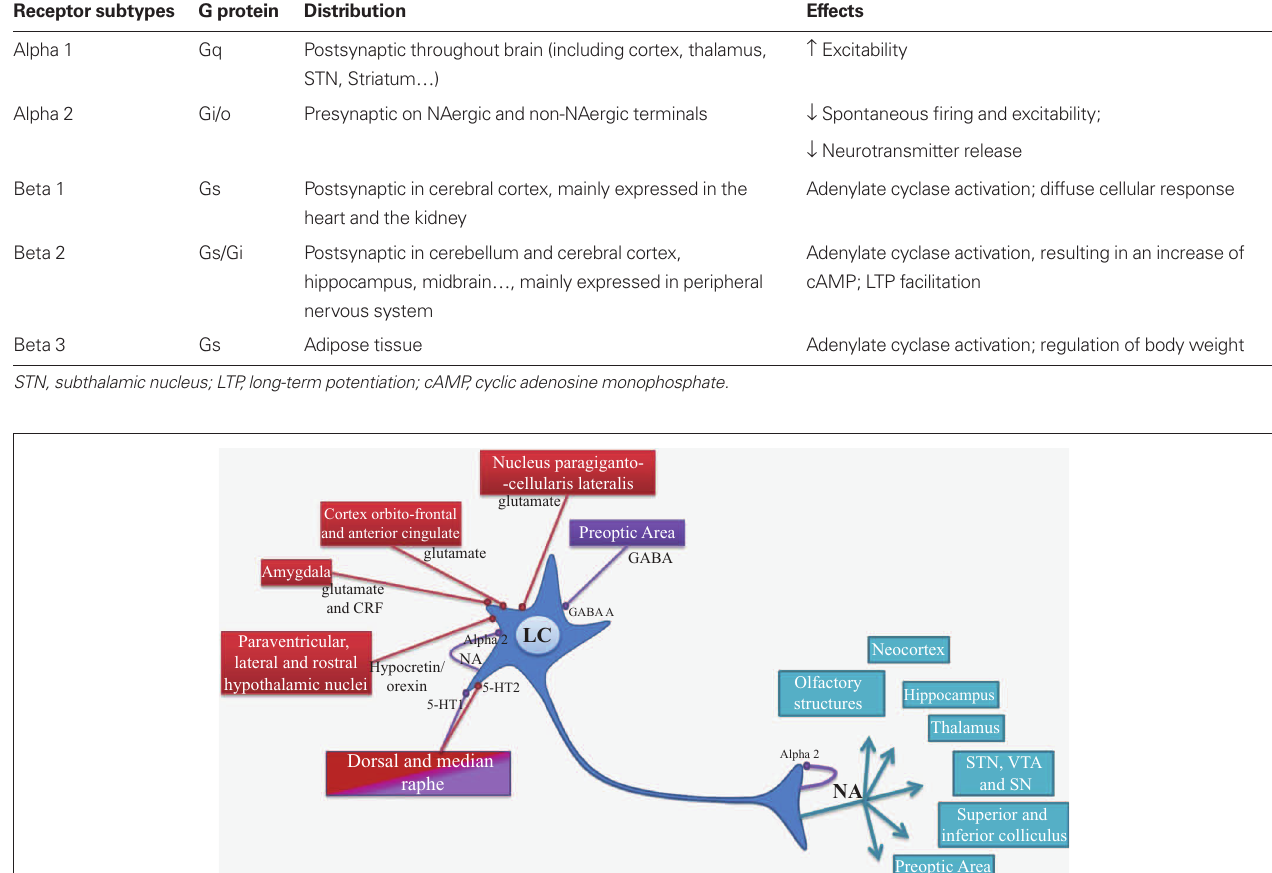
Table 1 | Adrenergic receptor characteristics. receptor subtypes g protein